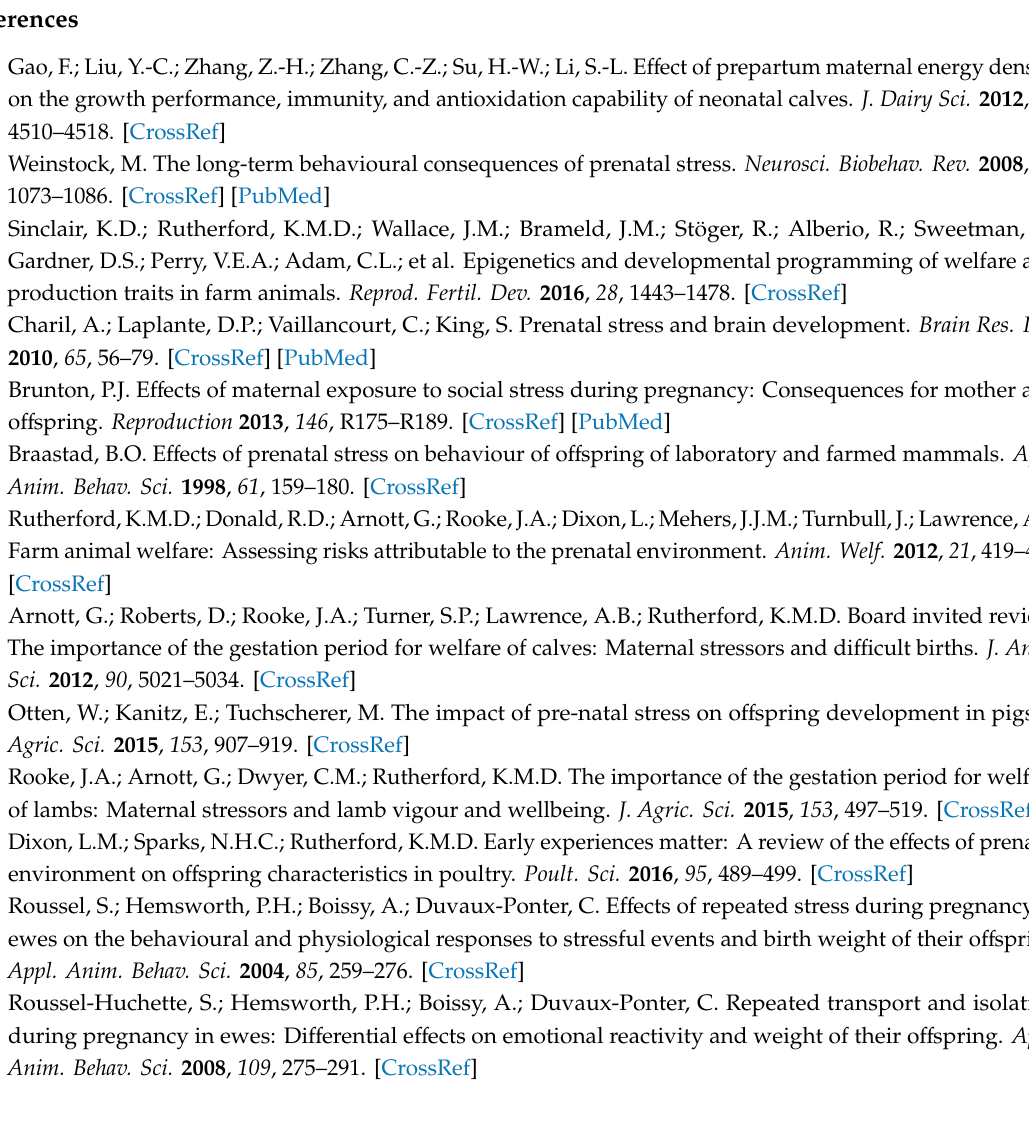
Table S1: Median latencies (IQR) calculated from raw data for each of the behaviours and hazard ratios [95% CIs] of L calves in performing each of the behaviours during the first 30 min in the group pen, Table S2: Time spent on each of the behaviours, the location (duration) and the frequency of each of the behaviours observed in the first 30 min in the group